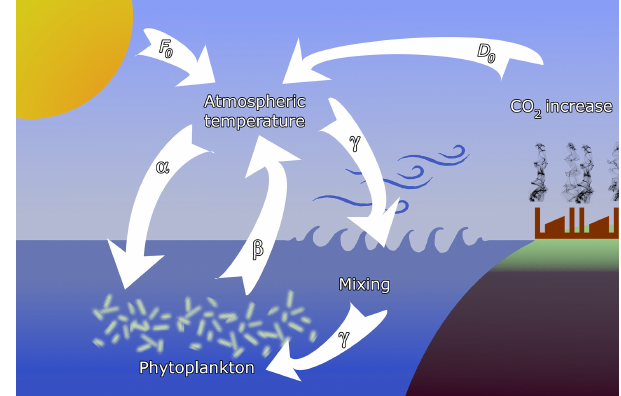
Figure 1. Sketch of the feedbacks considered in the model. Tem- perature contrast F 0 between the pole and the Equator, containing also seasonal variability, is augmented by anthropogenic effects D 0 . The main interactions are ( α ) the enrichment effect of atmospheric temperature on phytoplankton, ( β ) the extraction of CO 2 by phyto- plankton, and ( γ ) oceanic mixing, driven by atmospheric dynamics, affecting phytoplankton